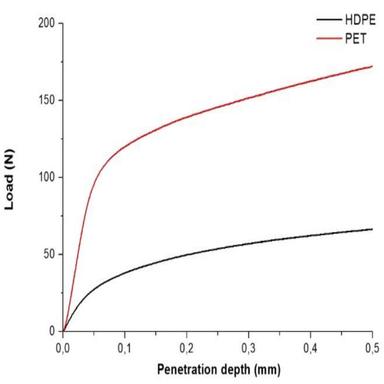
Results of FIMEC test performed in position P5 on HDPE and PET.